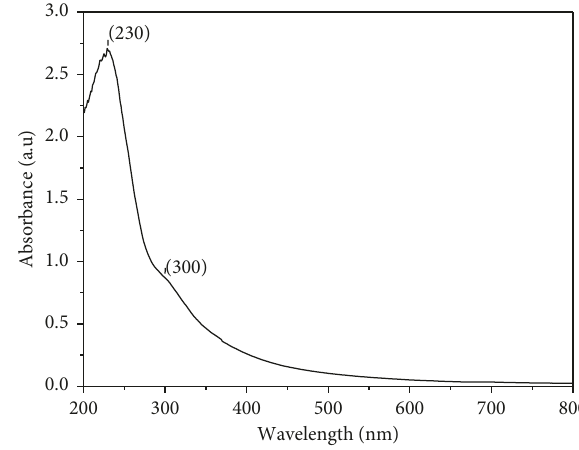
Figure 1: UV–Vis spectra record of GO.